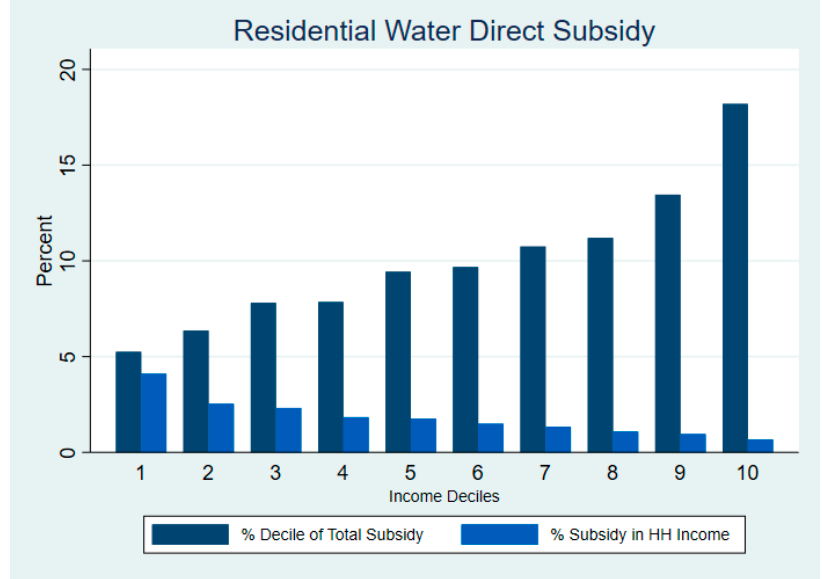
Figure 10. Residential water subsidies, 2014. Source: Own calculations with data from ENIGH [25]; and PIGOO [27]. Water 2019 , 11 , x FOR PEER REVIEW 20 of 27